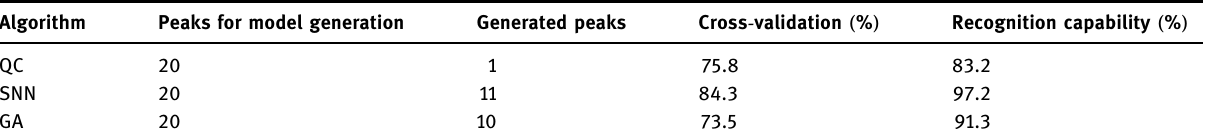
Table 2: Cross - validation and recognition capability of algorithms for the di ff erentiation of the TMD from the control set in the whole saliva samples